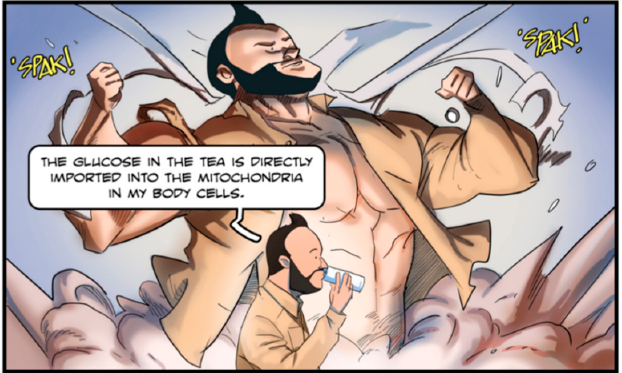
Figure 4. Power flash moment.